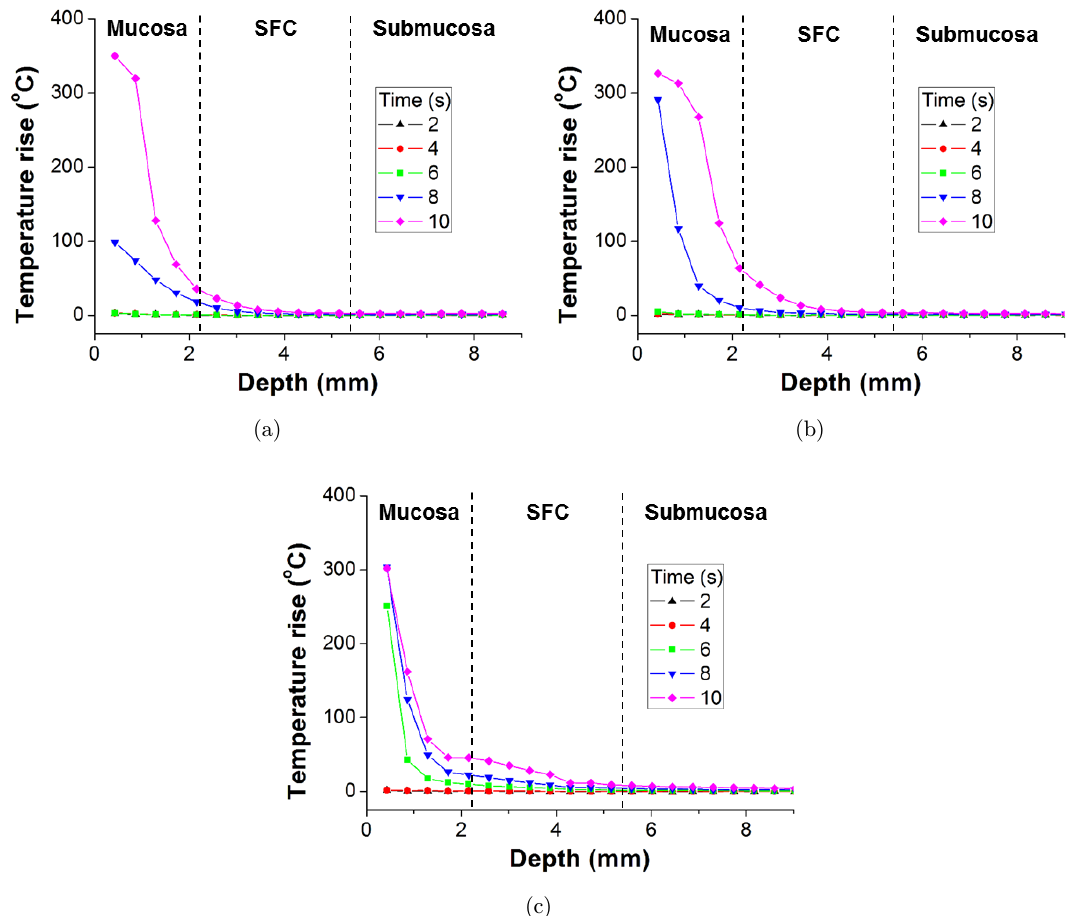
Fig. 9. E®ect of SFC on temperature rise in porcine stomach tissue sample with laser irradiation at 5 W for 30 s. Depthwise temperature pro¯les with increasing time at three di®erent concentrations of methyl blue solution. (a) 0.01%, (b) 0.1% and (c)